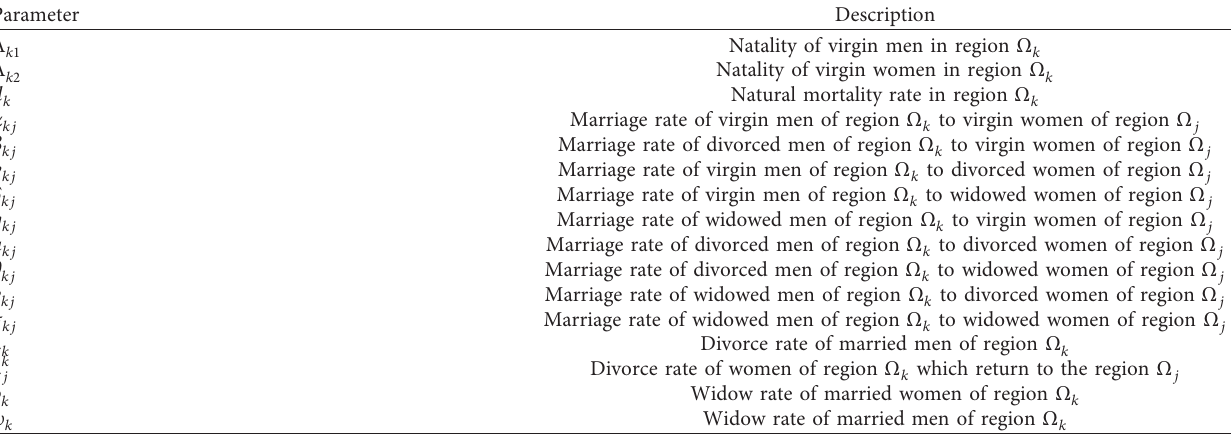
Table 1: The description of parameters used for the definition of discrete-time systems